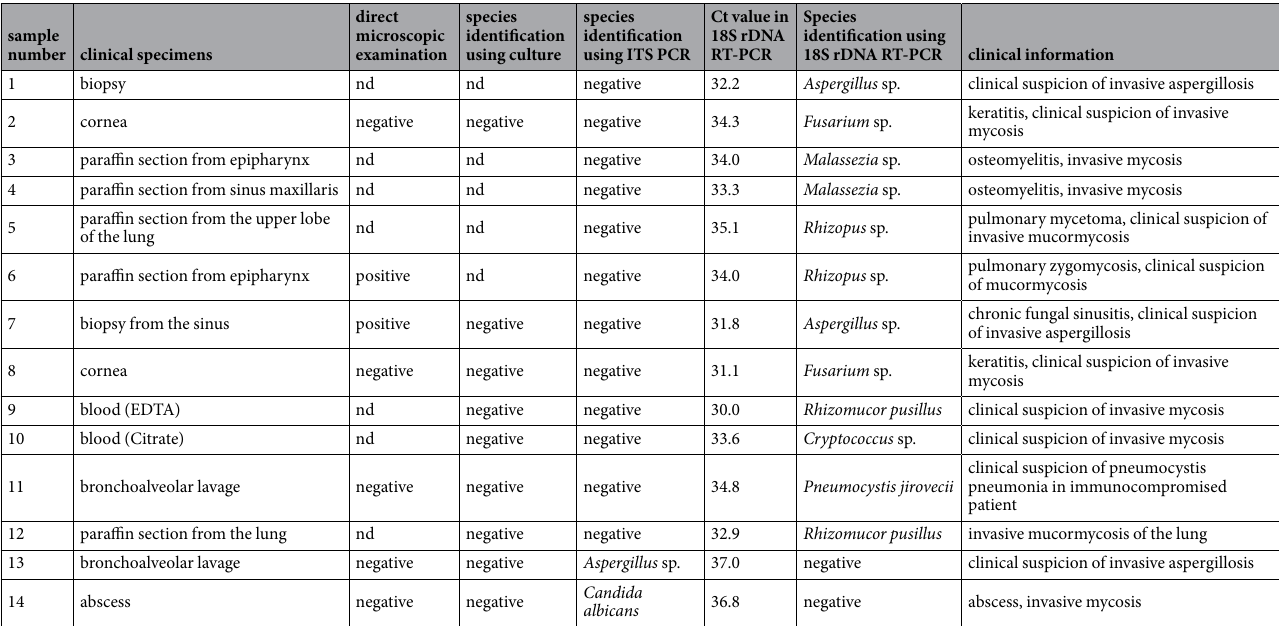
Table 2. Clinical specimens (N = 14) that showed discrepant results in fungal identification by ITS PCR and 18S rDNA RT-PCR. nd = not